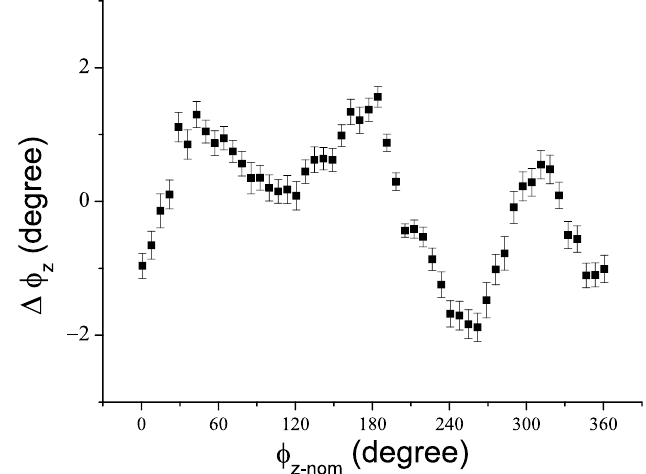
Figure 9. The measurements plotted in Figure 8 are analyzed to quantify the angular uncertainties. Mean value and standard deviation of the estimated angle are evaluated after each step. The standard deviation is represented with the error bars, while the mean value (corrected for non-monotonicity) is plotted having subtracted of the nominal angle φ z − nom . The error bars provide an estimate of the instrumental precision, and the difference ∆ φ z between estimated and nominal angles is a measure of the